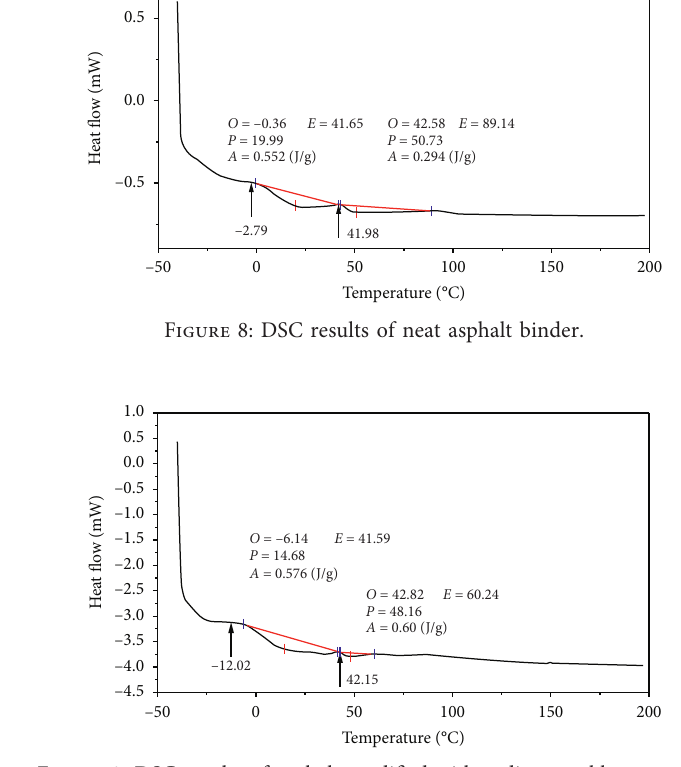
Figure 9: DSC results of asphalt modified with ordinary rubber powder.